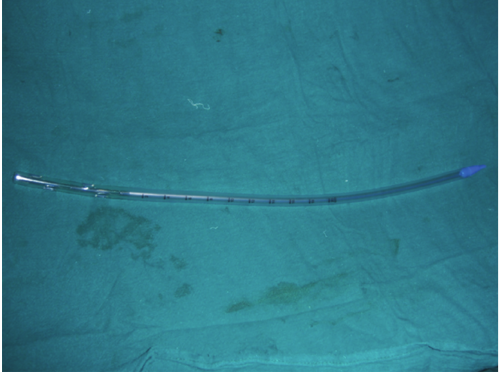
Figure 2: Drainage tube 32